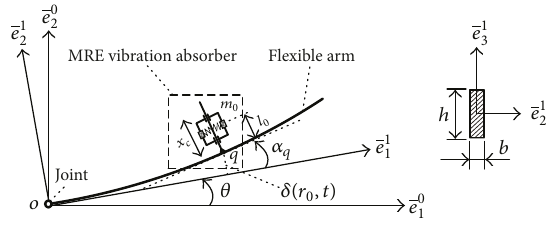
Figure 1: Dynamics model of the